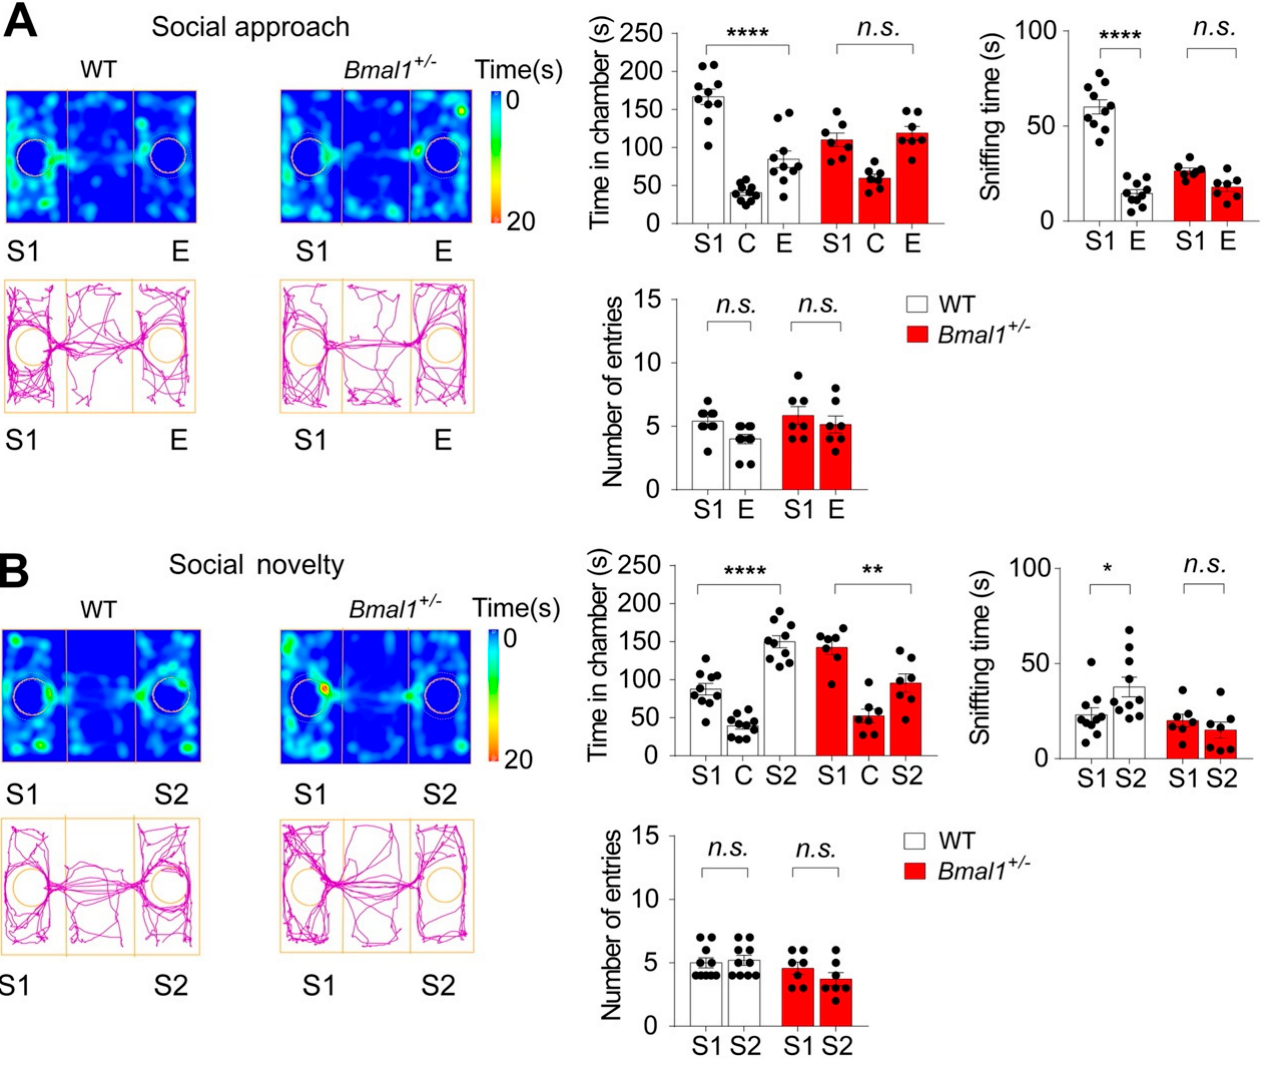
Figure 3. Impaired sociability and preference for social novelty in Bmal1 +/ − mice as determined by the three-chamber sociability tests. ( A ) The Bmal1 +/ − mice exhibited impaired sociability. Left: Representative images of heat maps (top) and track plots (bottom) of a WT and a Bmal1 +/ − mouse in the three-chamber sociability test. S1: stranger 1, C: center, and E: empty. The heat map indicates time spent at the location, and the track plot indicates the total distance traveled. Right: Bar graphs indicating time spent in individual chambers ( F (2,45) chamber × genotype = 15.21, p < 0.0001, two-way ANOVA), time spent sniffing each wire cage ( F (1, 30) chamber × genotype = 43.75, p < 0.0001, two-way ANOVA), and the number of entries to each chamber ( F (1, 30) chamber × genotype =0.4676, p = 0.4994, two-way ANOVA). Note that the WT mice spent more time in the S1 than E chamber, while Bmal1 +/ − spent similar time in the S1 and E chambers ( F (2,45) chamber = 50.37, p < 0.0001, two-way ANOVA and WT: S1 vs. E, p < 0.0001, Bmal1 +/ − : S1 vs. E, p > 0.9999, Bonferroni’s post hoc comparisons). WT mice also spent more time sniffing S1 than E, while Bmal1 +/ − spent similar times sniffing the S1 and E cages (F (1,30) chamber = 93.54, p < 0.0001, two-way ANOVA and WT: S1 vs. E, p < 0.0001, Bmal1 +/ − : S1 vs. E, p = 0.1109, Bonferroni’s post hoc comparisons). No difference was detected in the number of entries to the S1 and E chambers between WT and Bmal1 +/ − ( F (1,30) chamber = 4.445, p = 0.0435, two-way ANOVA and WT: S1 vs. E, p = 0.0752, Bmal1 +/ − : S1 vs. E, p = 0.7209, Bonferroni’s post hoc comparisons). n = 7– 10 mice/group. ( B ) The Bmal1 +/ − mice exhibited an impaired preference for social novelty. Left: Rep- resentative images of heat maps (top) and track plots (bottom) of a WT and a Bmal1 +/ − mouse in the three-chamber social novelty test. S1: stranger 1 and S1: stranger 2 (the novel stranger). Right: Bar graphs indicating time spent in individual chambers ( F (2,45) chamber × genotype = 21.97, p < 0.0001, two-way ANOVA), time sniffing wire cages ( F (1, 30) chamber × genotype = 4.928, p = 0.0341, two-way ANOVA), and